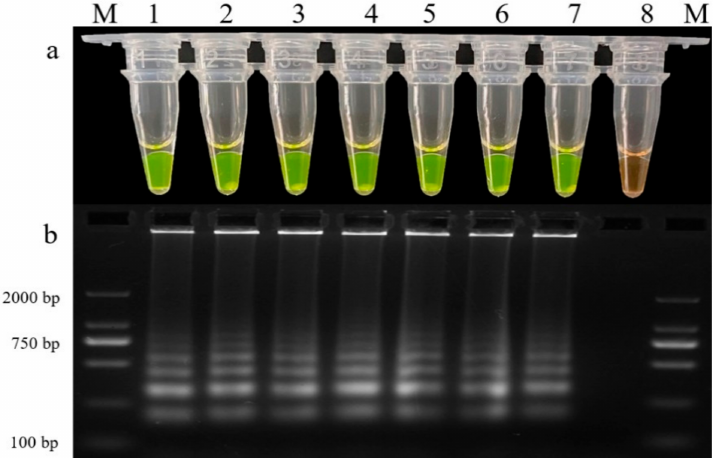
Figure 4. Profiles of LAMP reactions for P. graminea with serial concentrations of Bst DNA poly- merase. Assessments of LAMP products based on SYBR Green I visualization of color change ( a ) or agarose gel electrophoresis ( b ). Lane M, DNA ladder; tubes and lanes 1 to 7, LAMP reaction with Bst DNA polymerase concentrations of 2.0, 4.0, 6.0, 8.0, 10.0, 12.0, and 14.0 U, respectively; tube and lane 8, negative control with ddH 2